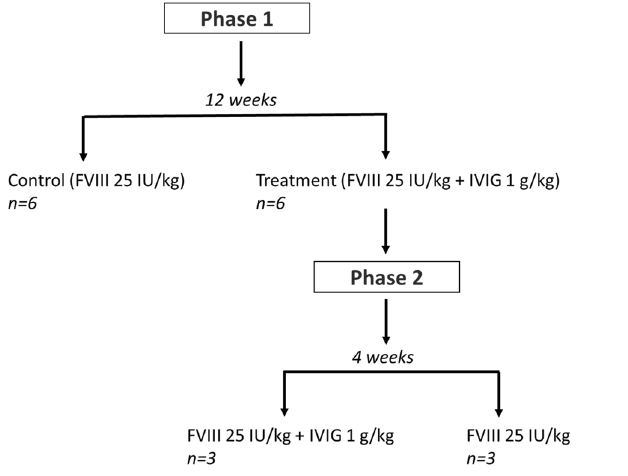
Figure 1. Experimental